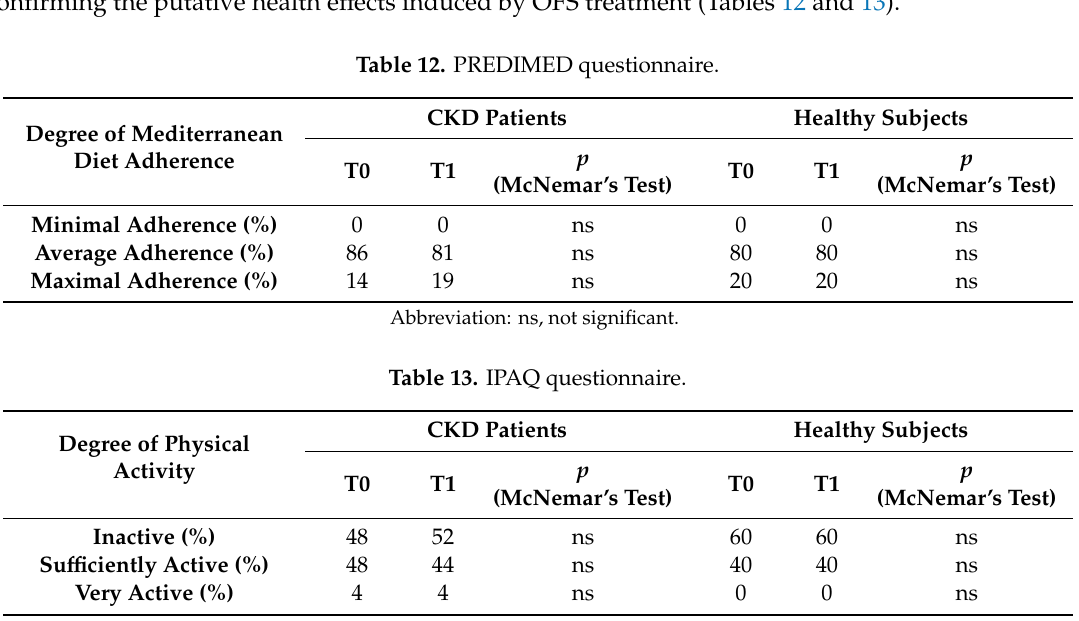
Figure 2. Pharmacological therapy on calcium-phosphorus metabolism.